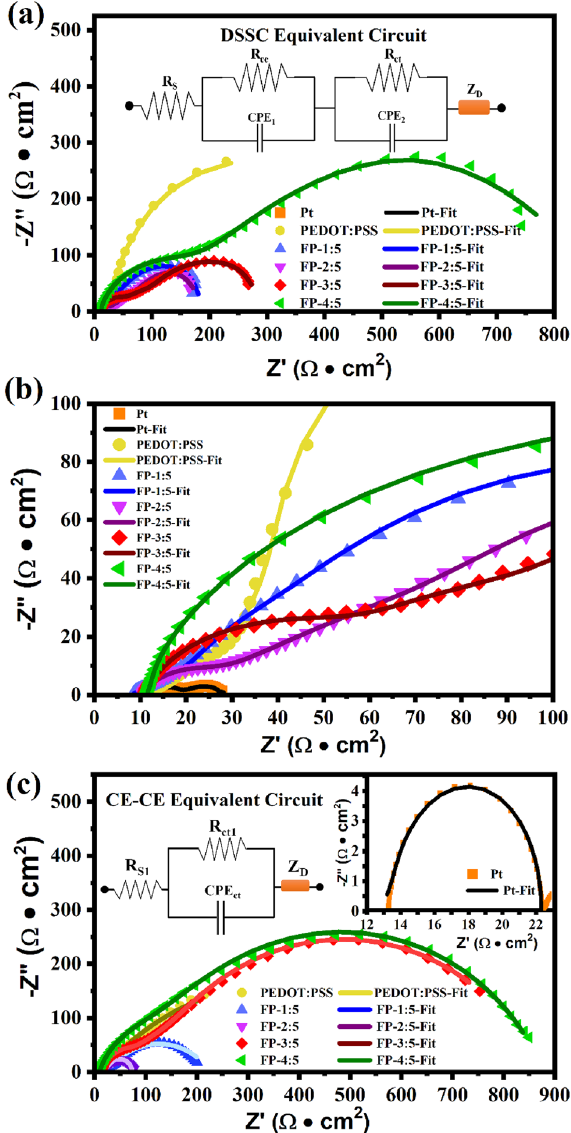
Figure 10. ( a ) Nyquist plots of the constructed DSSC cells and the inset DSSC equivalent circuit, ( b ) highly magnified Nyquist plots, and ( c ) Nyquist plots of the fabricated CE-CE cells (inset), the fabricated CE-CE equivalent circuit of prepared counter electrodes.